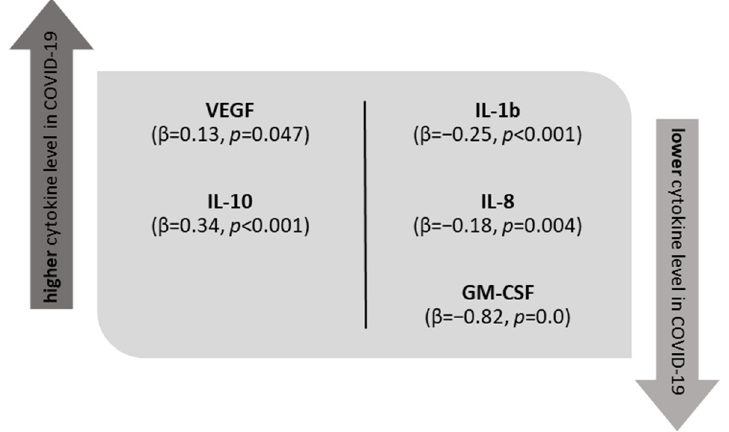
Figure 2. Graph showing the statistically significant results of the multivariate analysis adjusted for